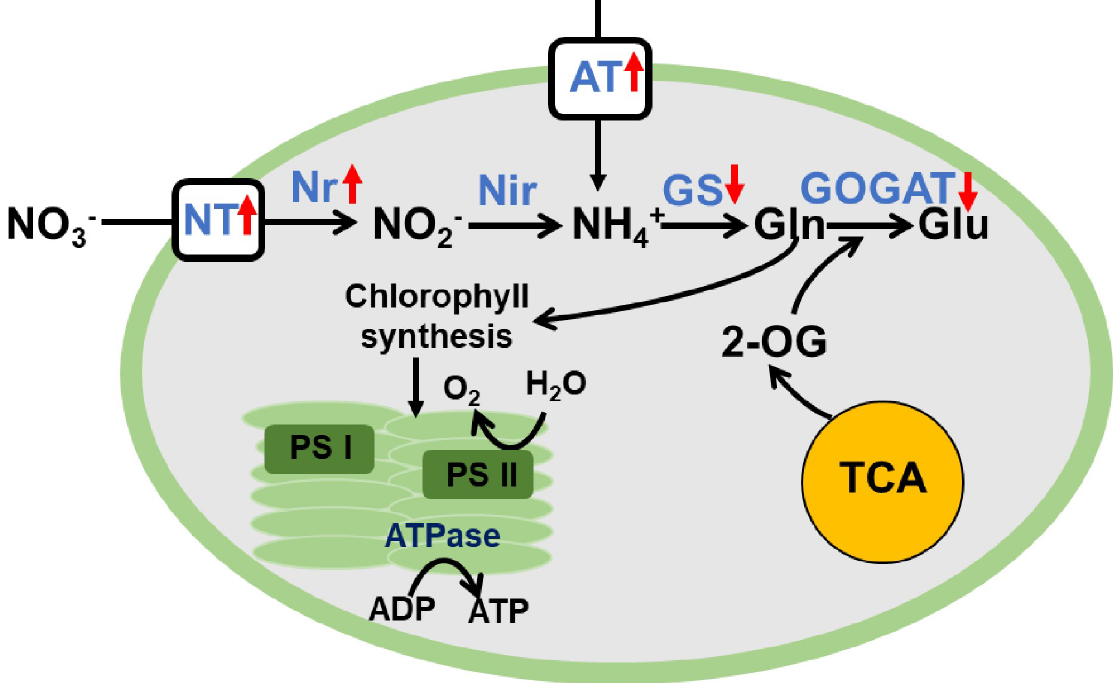
Fig 6. Differential expression analysis of genes related to nitrogen metabolism under ND in P . cruentum . The pathway of nitrogen assimilation was briefly constructed and the transcriptional change of sever unigenes was presented with arrow. “ " ” and “ # ” represented upregulation and downregulation under ND,